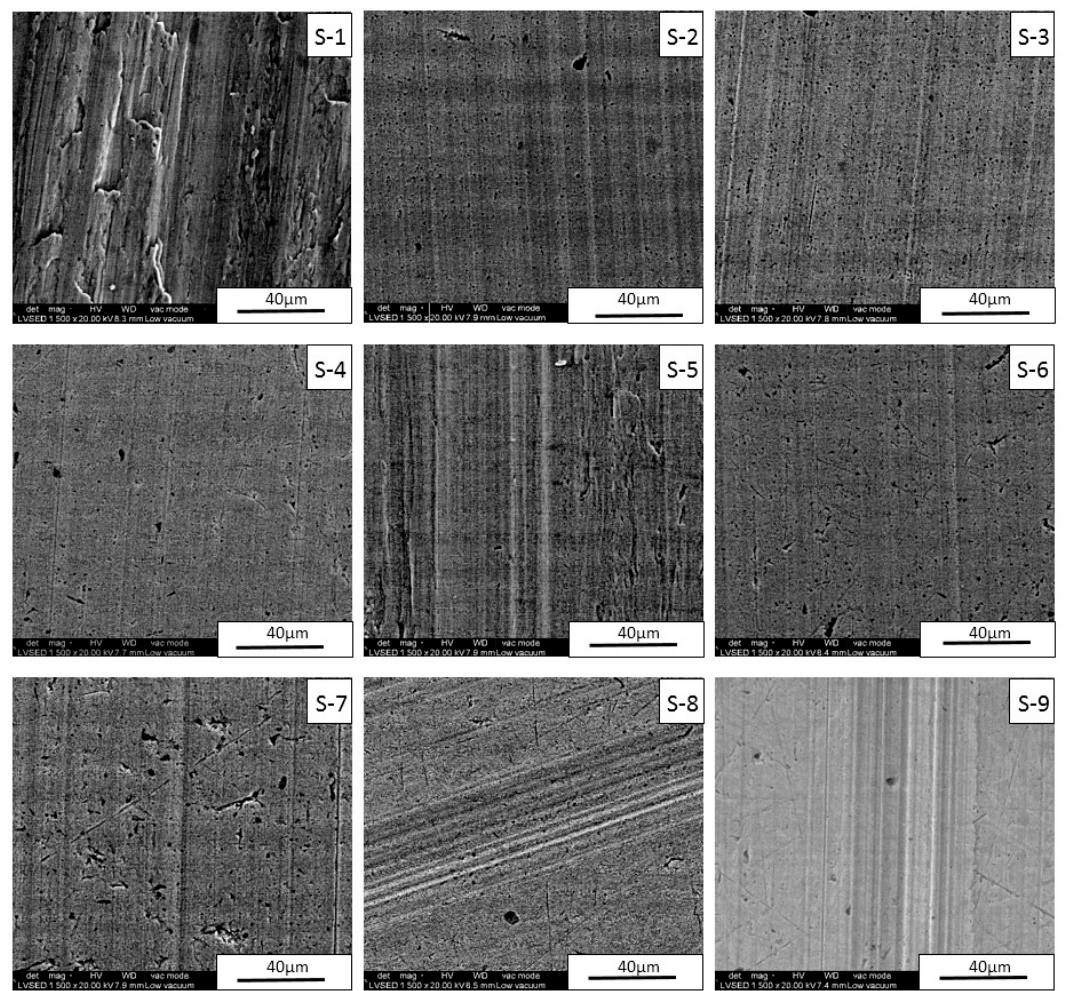
Figure7. Worn scar evaluation in a lowvacuum chamber at 40 µ m scale using SEMfor nine disk Figure 7. Worn scar evaluation in a low vacuum chamber at 40 µm scale using SEM for nine disk samples.